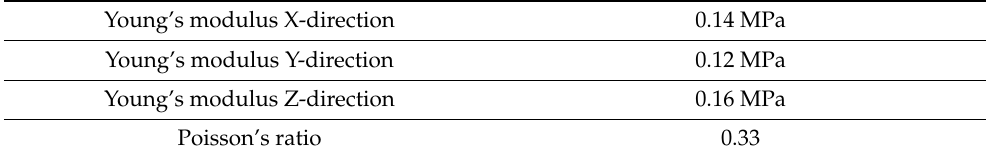
Figure 1. The RVE model and its details: ( a ) BNNTs; ( b ) polymer matrix; and ( c ) the combination of polymer matrix and BNNTs. Table 2. Material properties of the scaffold.